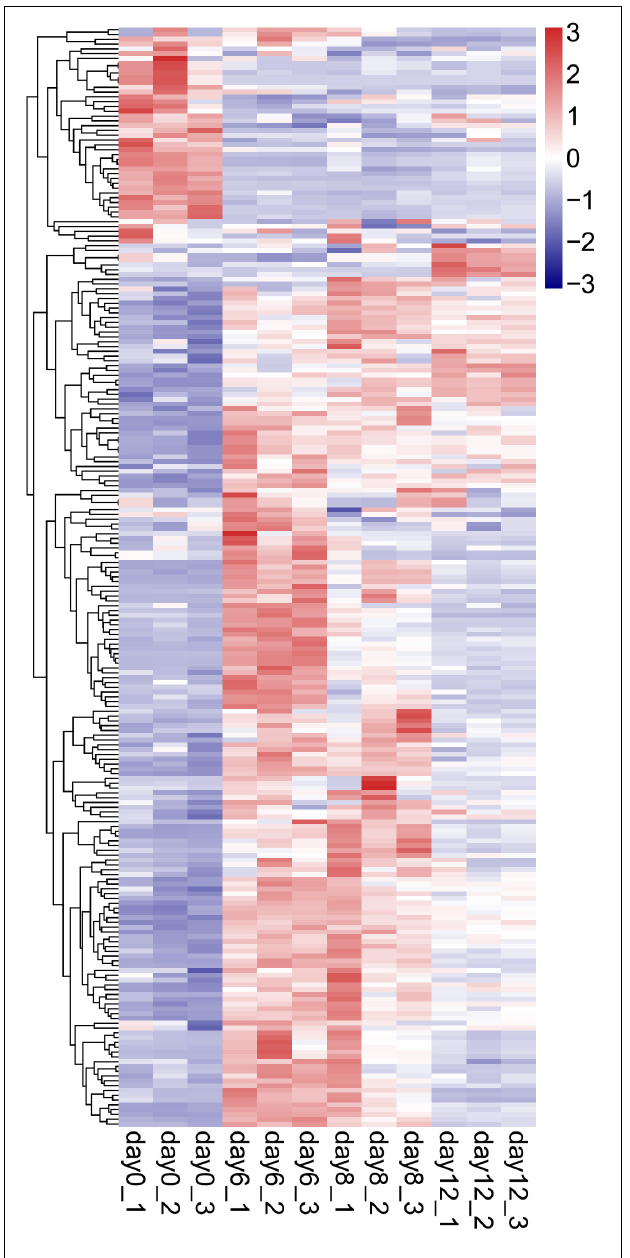
FIGURE 6 | Hierarchical clustering analysis of DEGs differential expression genes (DEGs) in the 4 stages of developmental pearl sac of H. cumingii . The gene-normalized signal intensities are shown in the heat maps using a log 10 scale.